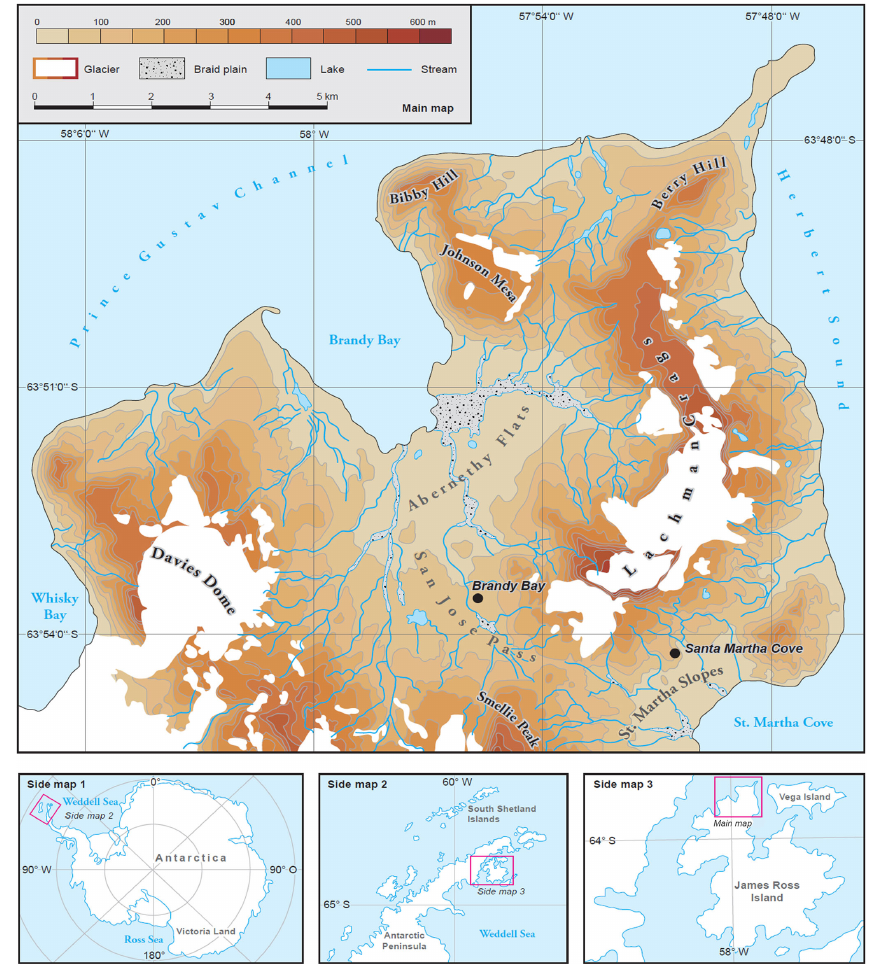
Figure 1. The main map shows the regional setting of the Ulu Peninsula on James Ross Island, maritime Antarctica. Black circles indicate the location of both study sites, Brandy Bay (BB) and Santa Martha Cove (SMC). Side maps 1–3 provide an additional overview over Antarctica, the Antarctic Peninsula region and James Ross